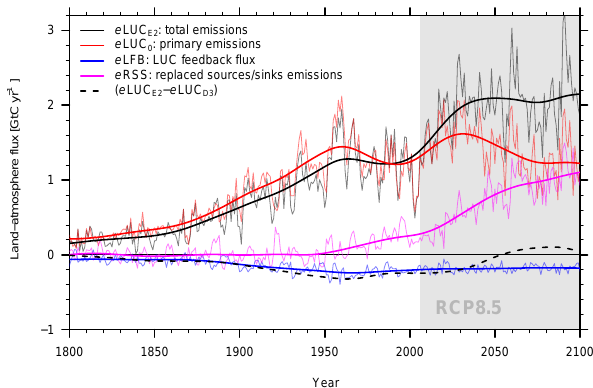
Figure 3. Flux components of land use change emissions. Total emissions as derived from an emission-driven, coupled ESM setup (E2 method), and calculated with Eq. (4), are given by the black lines. Primary emissions under preindustrial boundary conditions are given by red lines. These correspond to curves in Fig. 2. The replaced sinks/sources flux ( e RSS) and the land use change feed- back flux ( e LFB) are given by magenta and blue lines, respectively. The difference between total emissions quantified by D3 method (see black solid line in Fig. 2) and E2 method is given by the black dashed line. Time series are calculated following Eqs. (2), (4), (15), and (16). Bold lines are splines of annual emissions given by thin lines. Results are from simulations following CMIP5 model inputs (historical until 2005, RCP8.5 until